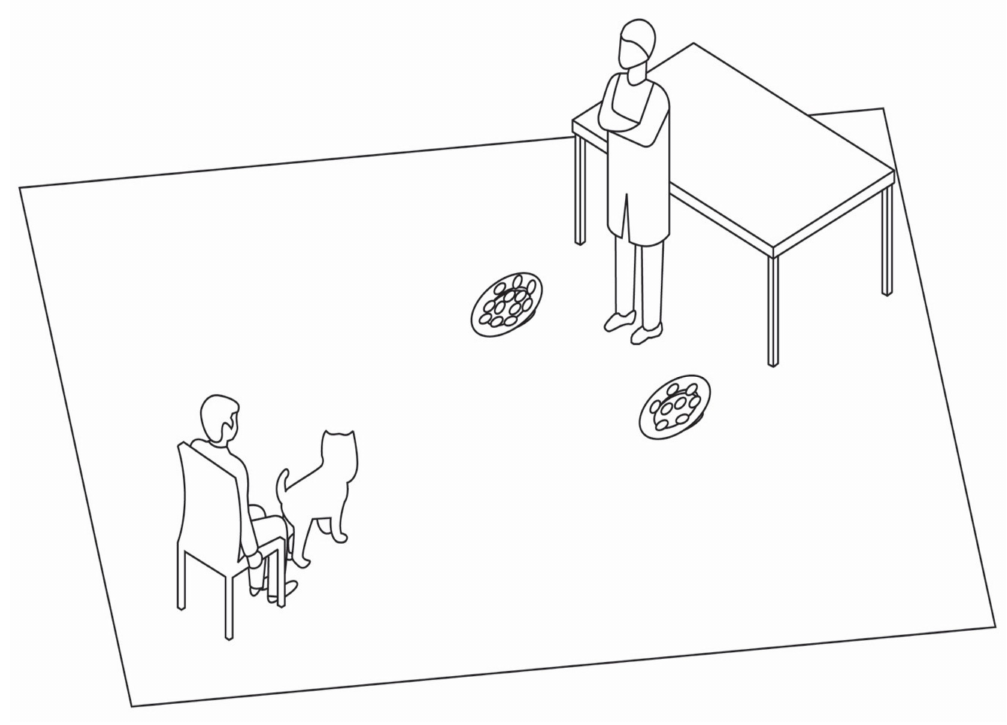
Figure 2. The experimental setting in Experiment